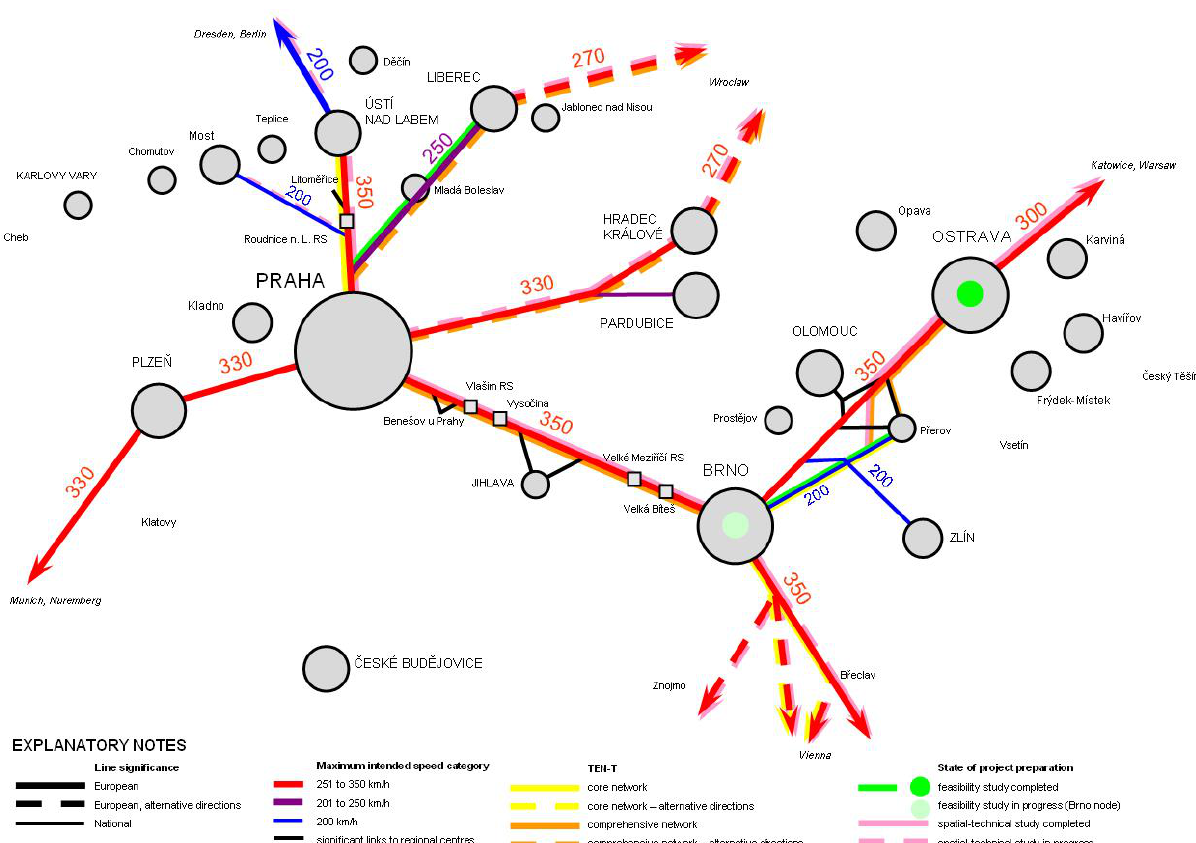
Figure 1. Maximalist Czech HSL